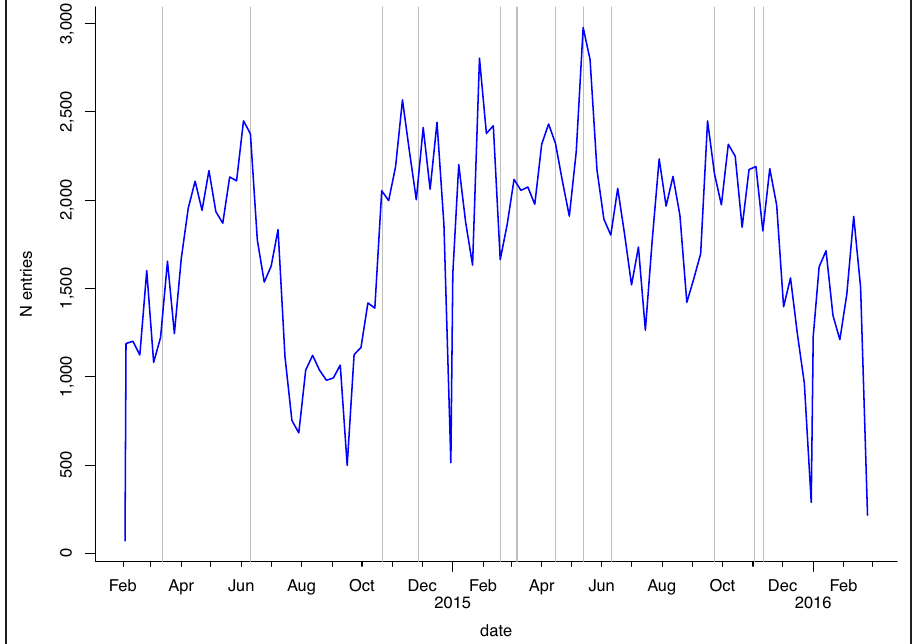
Figure 3: Total number of entries per week. Vertical reference lines mark the events and workshops listed in tables 5 and